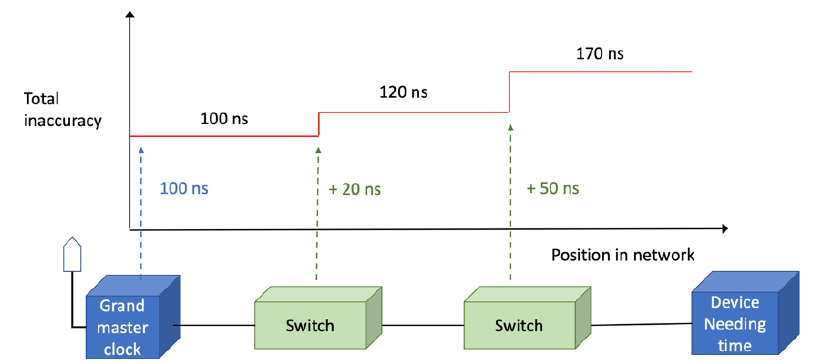
Figure 6. The PTP accuracy TLV (message extension) is loaded by the Grandmaster clock and updated by each switch and router through which the message passes. End devices can review the accumulated inaccuracy value to determine whether they are receiving time with sufficient